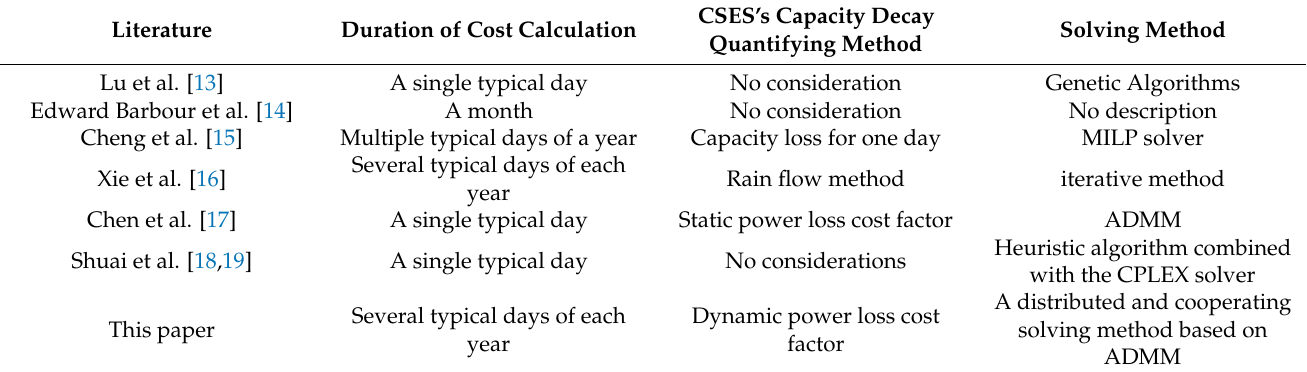
Table 1. The comparison of the work of this paper with other